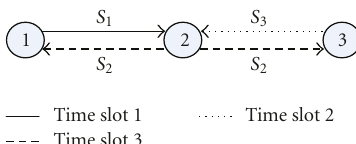
Figure 3: Straightforward network coding scheme.